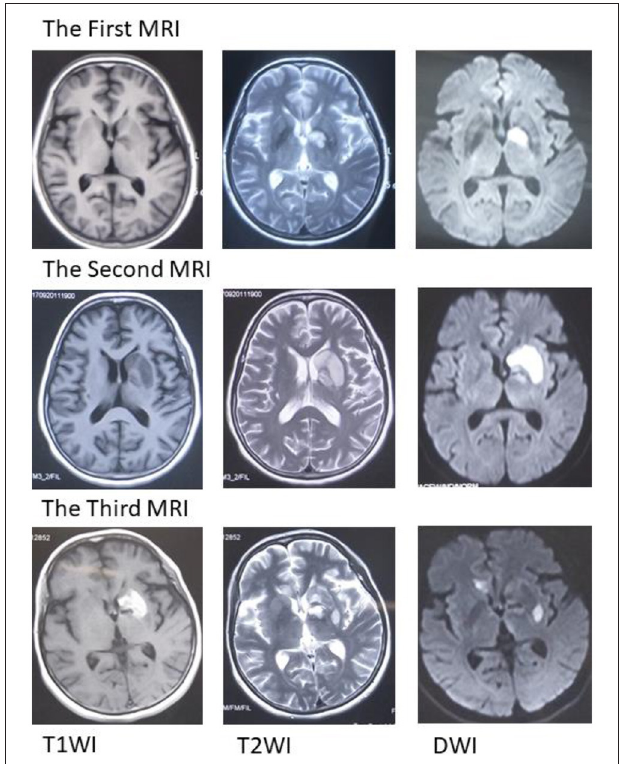
FIGURE 1 | Magnetic resonance imaging (MRI). The first MRI suggests an acute infarct in the left basal ganglia. The second MRI scan suggests an expanded infarct in the left basal ganglia. The third MRI suggests acute infarction in the left basal ganglia and right callosum genu and bleeding in the left basal ganglia. MRI, magnetic resonance imaging; T1WI, T1-weighted imaging; T2WI, T2-weighted imaging; DWI, diffusion-weighted imaging.